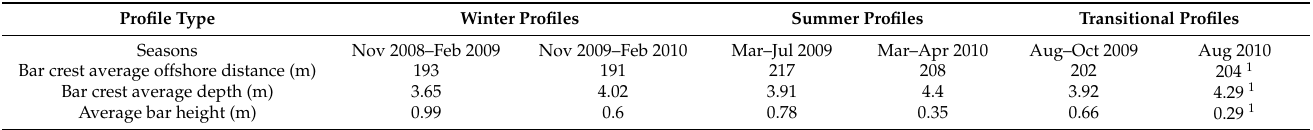
Table 1. Outer bar average characteristics for different profile groups for November 2008–August 2010. Profile